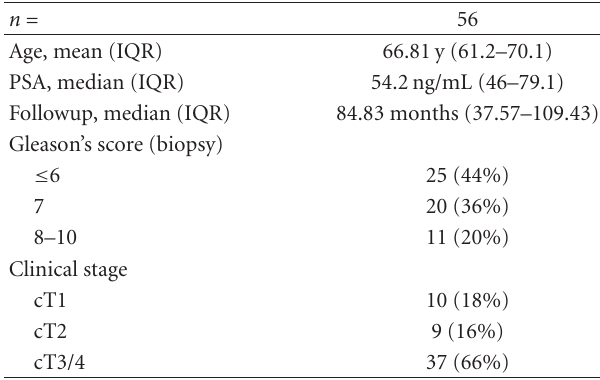
Table 1: Preoperative patient characteristics (IQR: interquartile range).